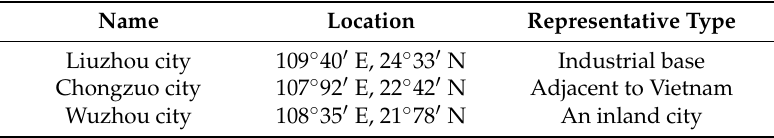
Table 1. Information about the three points for the backward trajectory analysis.